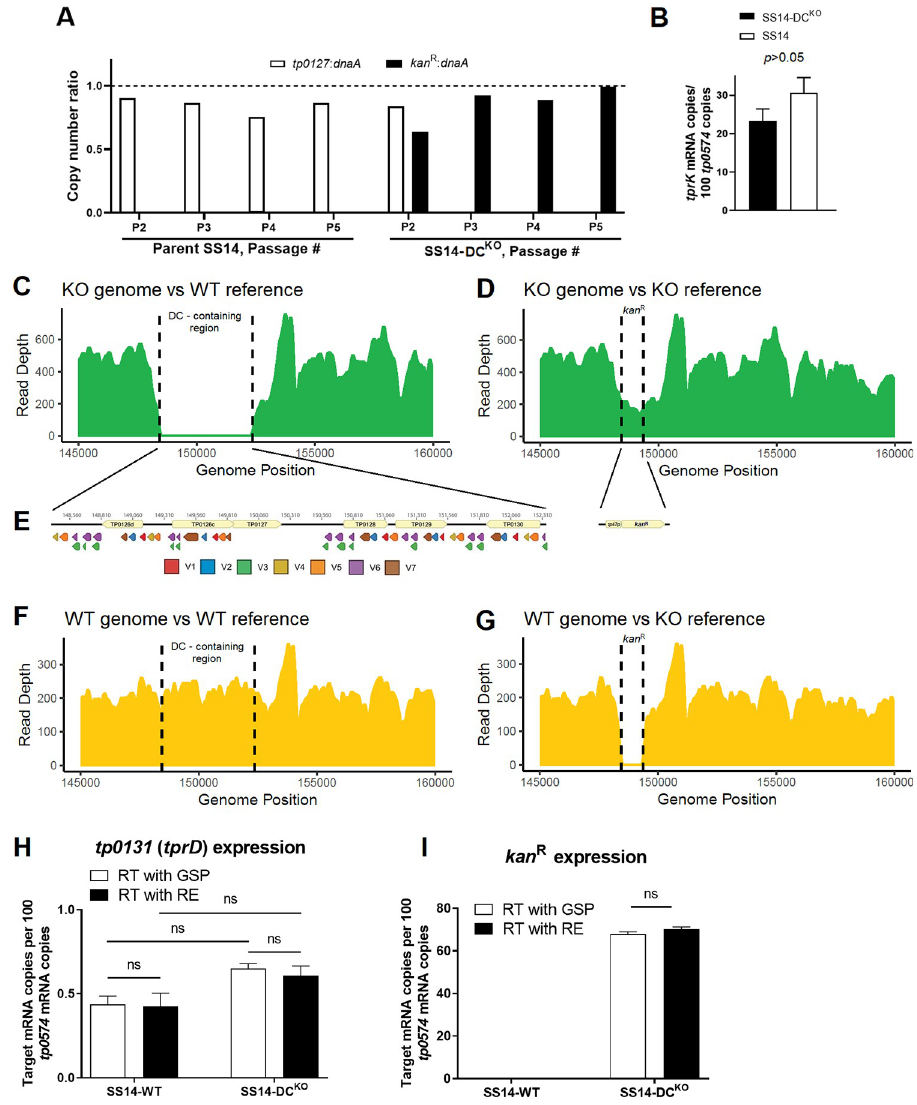
Fig 3. Confirmation of kan R cassette integration using ddPCR and WGS, and message quantifications. (A) Ratios between the kan R , dnaA (tp0001) , and tp0127 (contained within the deleted DC) copy number determined by droplet digital PCR (ddPCR) on template DNA from the SS14-DC KO and parent SS14 strain harvested at passage #2–5 post- transformation. The kan R : dnaA ratio for the parent SS14 was zero at each passage. (B) Message quantification of tprK (normalized to tp0574 ) in SS14-DC KO and parent SS14 strain propagated in vitro showing comparable expression of tprK between the control and transformed strain. Significance ( p < 0.05) was assessed by performing Student’s t -test. (C-G) Whole-genome sequencing of the SS14-DC KO and WT strains (passage #9) post-transformation. ( C ) SS14-DC KO reads assembled to the WT genome reference (NC_021508.1/CP004011.1) showing a gap where the DC locus previously was. (D) SS14-DC KO reads assembled to the SS14-DC KO reference genome, where the DC locus was replaced in silico with the kan R cassette sequence showing reads aligning to the cassette sequence. (E) Schematic of the 51 deleted DCs, color-coded based on their target V region and the kan R cassette ( tp0574 promoter- kan R ) that replaced the DCs. (F) Reads from the WT SS14 genome aligned to the SS14 reference genome showing the integrity of the DC locus. ( G ) Reads from the WT genome aligned to the SS14-DC KO reference genome showing a gap where the kan R cassette is located. ( H-I ) Messsage quantification of the tp0131 and kan R genes in the WT and the SS14-DC KO strain showing lack of transcriptional polar effects due to the substitution of the DCs. mRNA was reverse-transcribed using either gene-specific primers (GSP, white bars) or random hexamers (RE; black bars); ns: not significant.